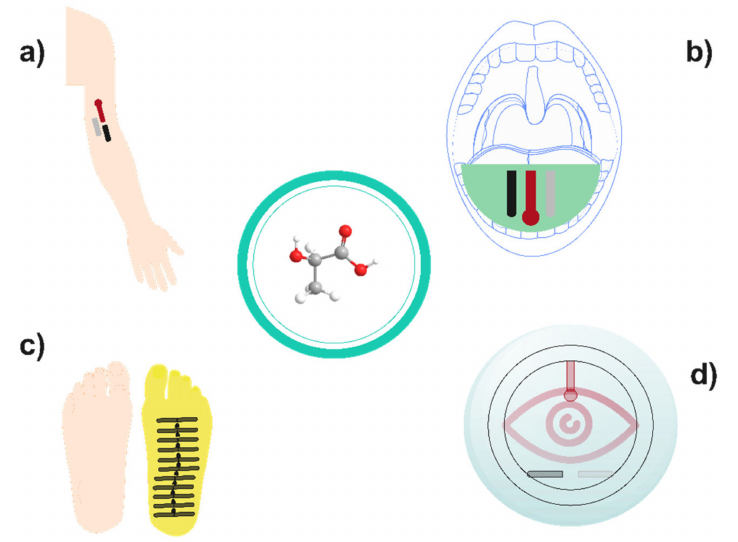
Figure 6. Several wearable lactate sensor examples: epidermal tattoo ( a ) [85], mouthguard ( b ) [84], bioelectronic sock ( c ) [86] and biosensor lens ( d )